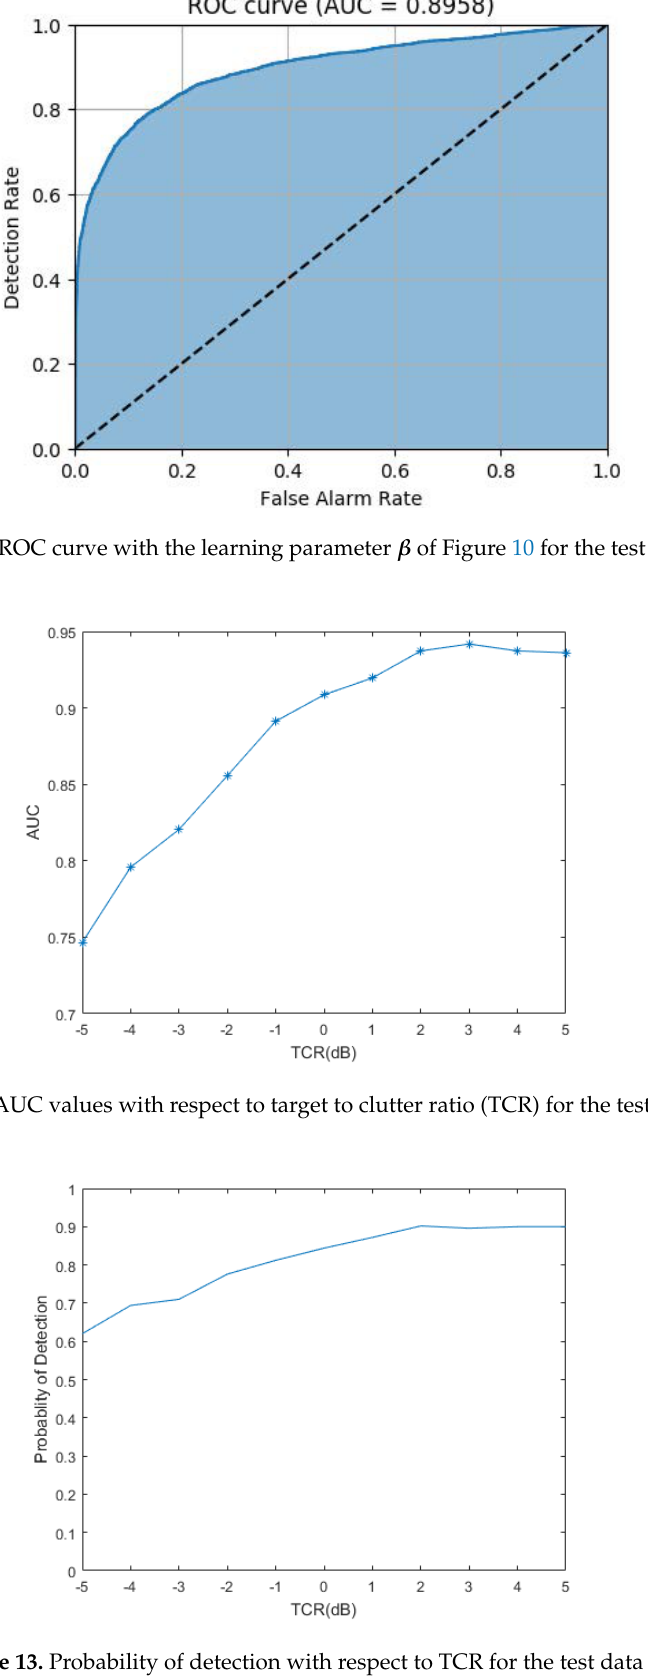
Figure 13. Probability of detection with respect to TCR for the test data